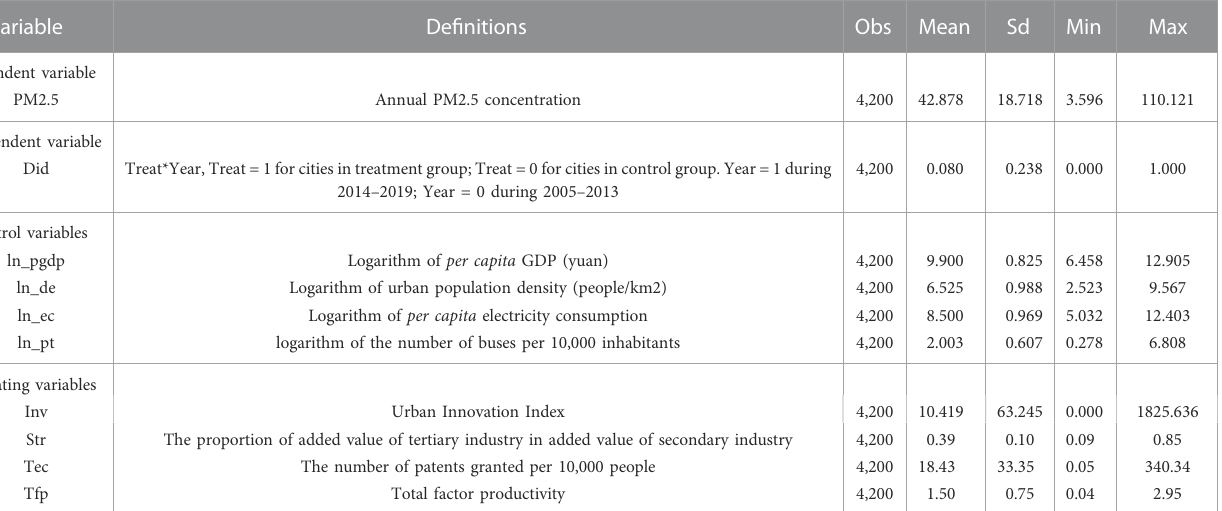
TABLE 1 Variables ’ de fi nitions and descriptive